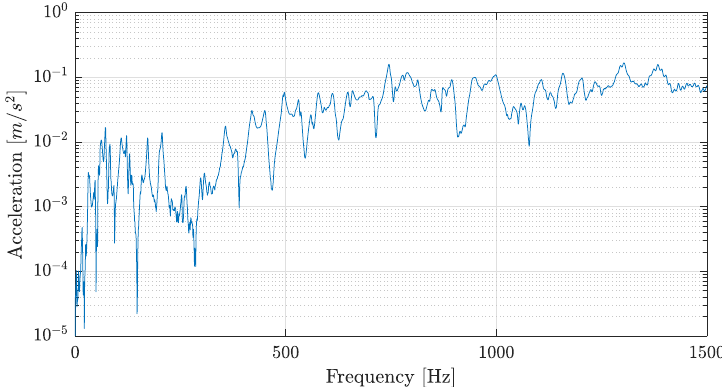
Figure 7. FRF example from the first accelerometer in the initial state.